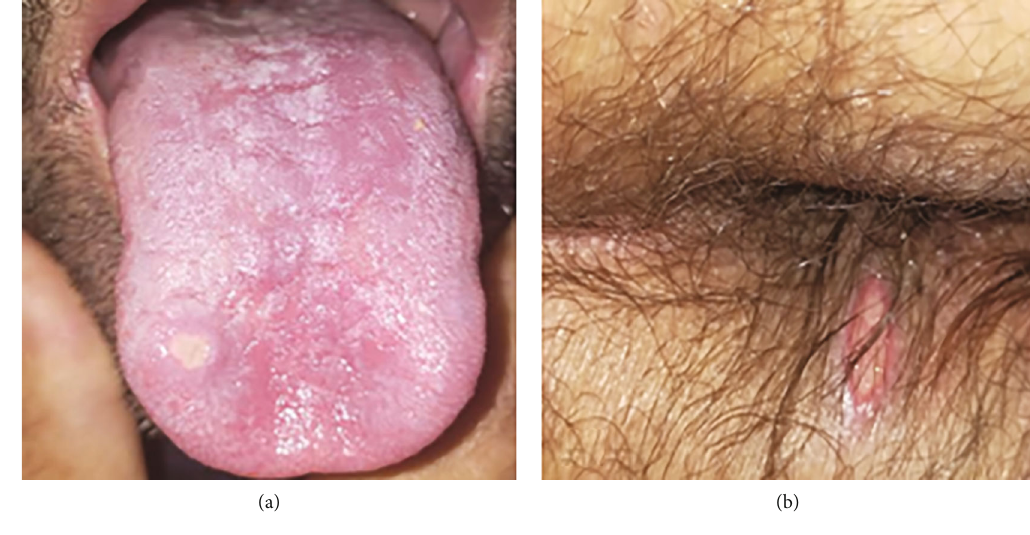
Figure 4: Oral (a) and genital (b)